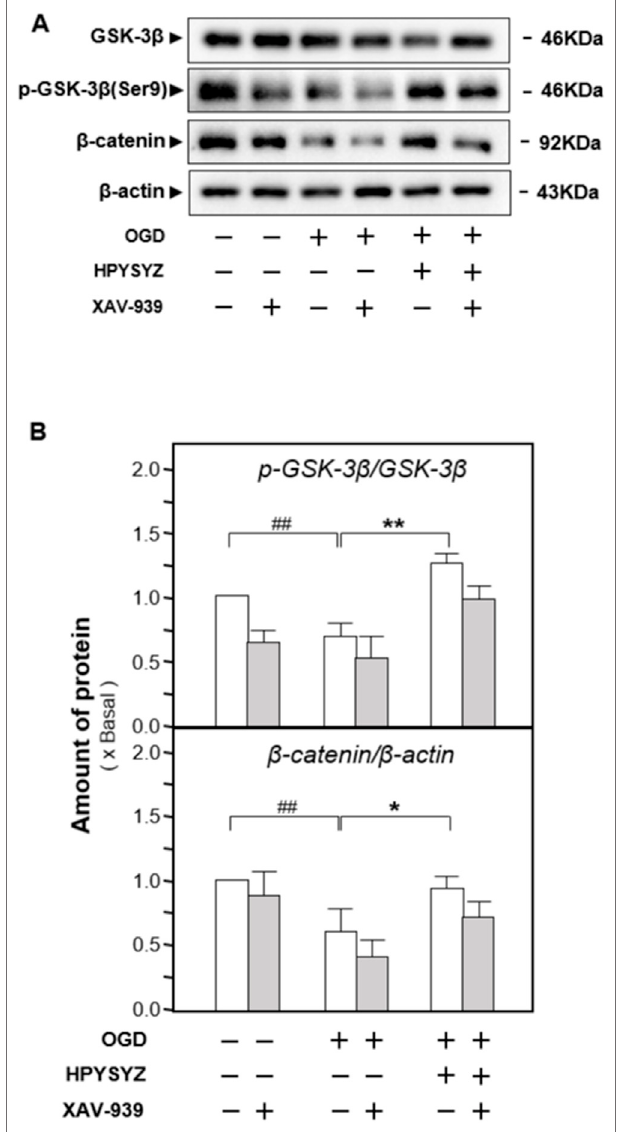
FIGURE 13 | Effect of co-treatment of XAV-939 and ethyl acetate extracts of succinum on regulating the GSK3 β / β -catenin pathway of HT22 cells under OGD condition. (A) Effect of ethyl acetate extracts of succinum (HPYSYZ) on the expressions of GSK3 β , p-GSK3 β (Ser9), β -catenin, and β -actin of HT22 cells under OGD condition were evaluated by Western blotting analysis. The representative images are displayed ( n = 5). (B) Expression ratio of p-GSK3 β to GSK3 β was calculated, and the expression of β -actin was applied for normalization. Expression ratio of p- β -catenin to β - catenin was calculated, and the expression of β -actin was applied for normalization. Values are expressed as mean ± SEM ( n = 5). Comparisons between groups were carried out by a one-way ANOVA followed by a post hoc Bonferroni test. ## p < 0.01, * p < 0.05, and ** p < 0.01.